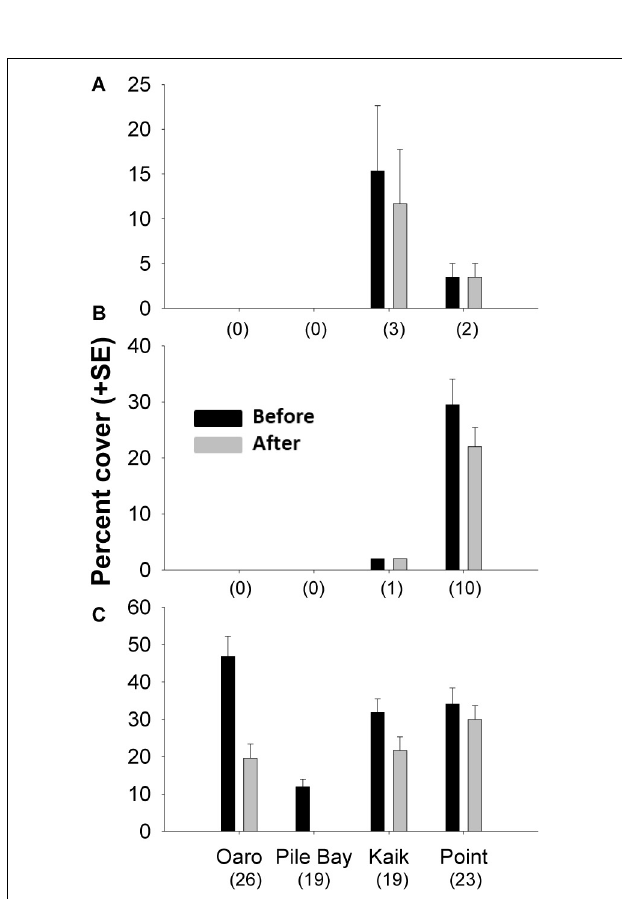
FIGURE 4 | Percent cover (+ SE) of Durvillaea antarctica (A) , D. willana (B) , and D. poha (C) before (black) and after (gray) the summer of 2017/18 on four intertidal reef platforms. Cover was estimated from paired 95 m 2 drone images that showed presence of bull kelp either before and/or after the hot summer of 2017/18. Replication levels are shown in brackets.